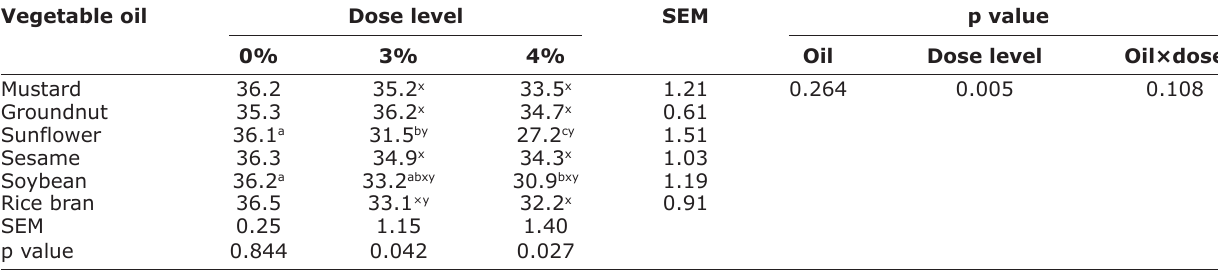
Table-3: Effects of vegetable oil supplementation on protozoal population in the rumen liquor after 24 h of incubation. Vegetable oil